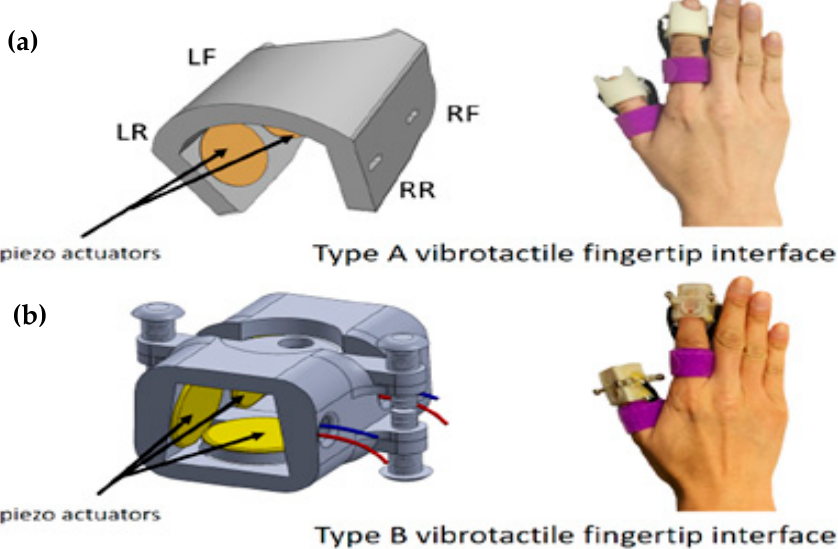
Figure 11. Three-dimensional model and screenshots of type-A ( a ) and type-B ( b ) tactile interfaces applied on fingertips. LF, LR, RF, and RR stand for the locations of the piezo actuator [83]. In a different study, the same researchers presented two finger-tip interfaces for the index and thumb fingers. The type-A interface was originally intended to generate 2.5D